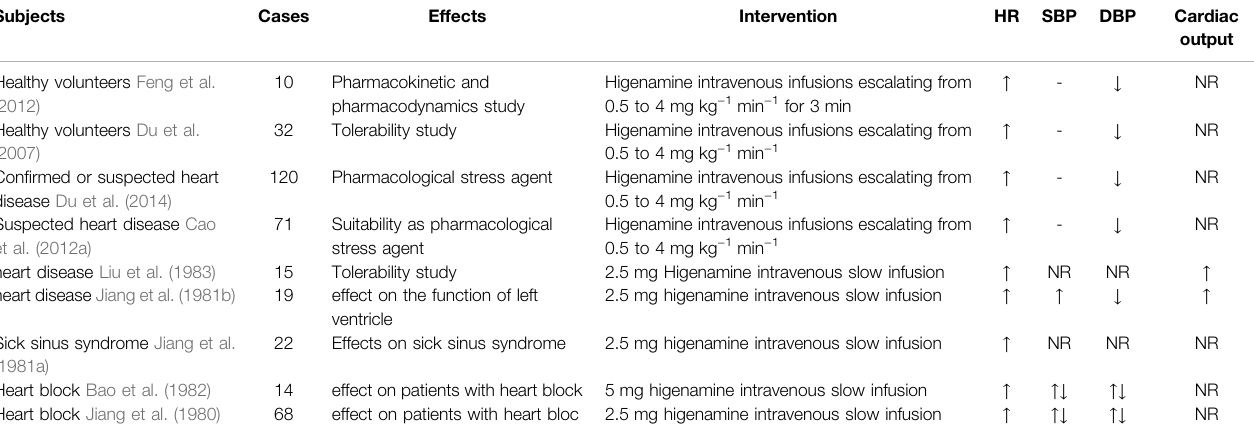
heart disease Liu et al. (1983) heart disease Jiang et al. (1981b) Sick sinus syndrome Jiang et al. (1981a)